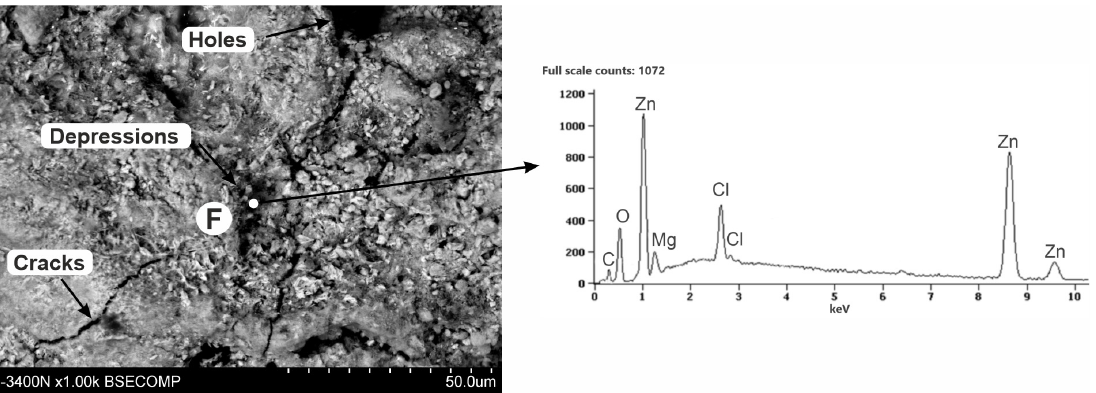
Figure 10. SEM images and corresponding EDS patterns of the corroded ZAMS coating after the removal of white corrosion products with visible cracks, depressions, and holes.